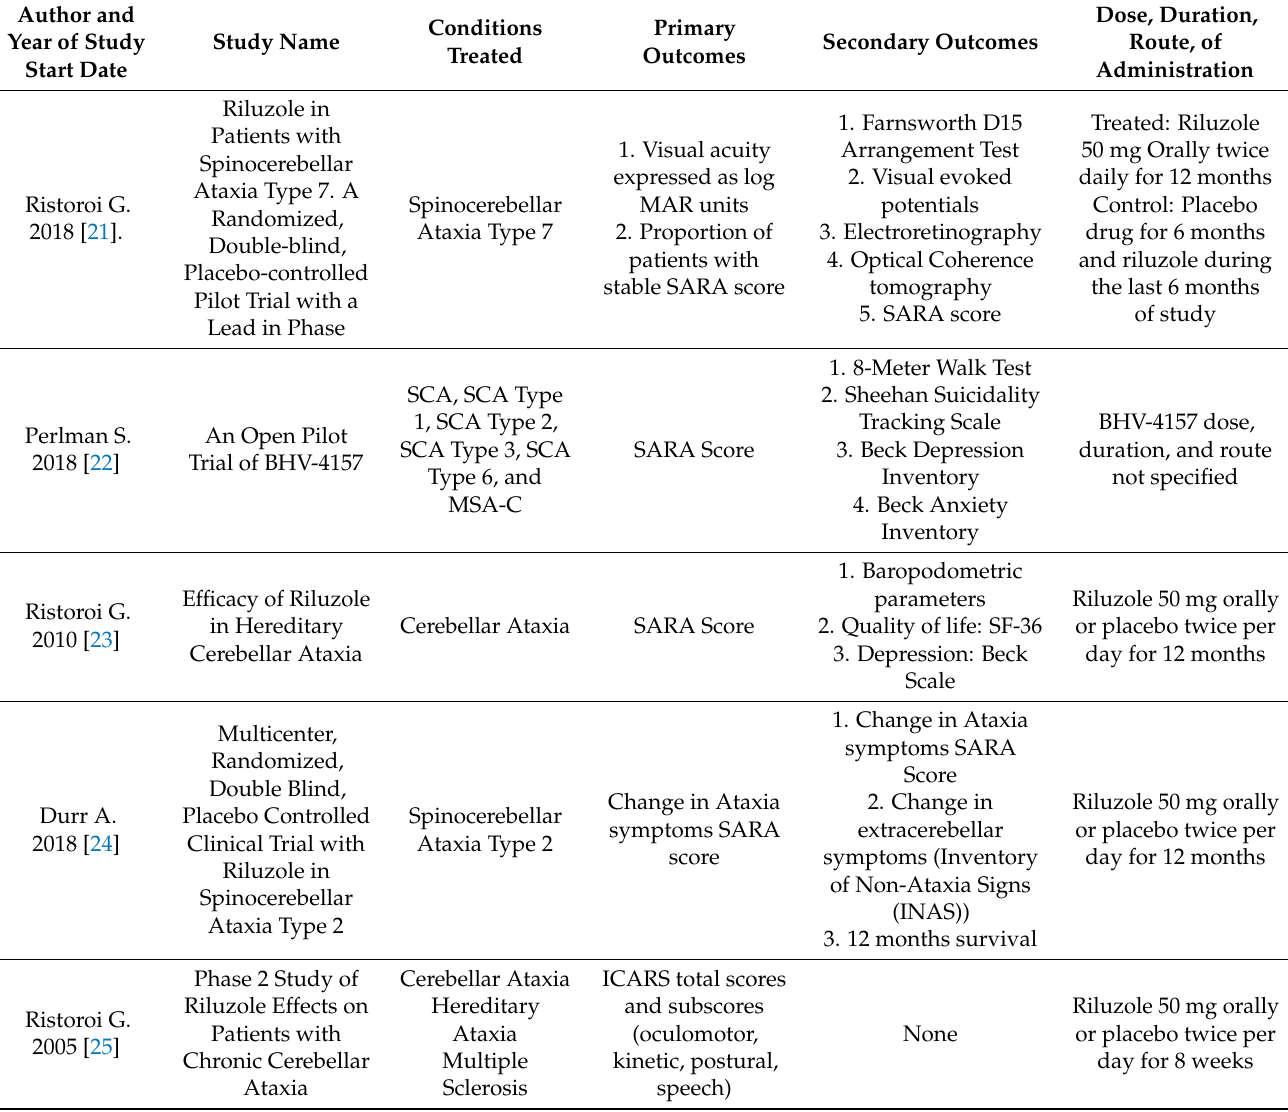
Table 4. Ongoing clinical trials of Ataxia and